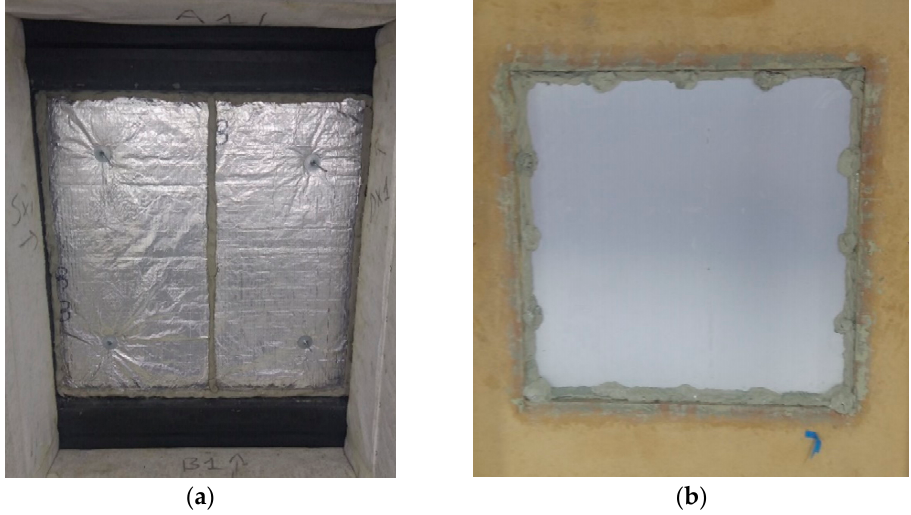
Figure 2. Experimental setup for STL measurement for benchmark solution: ( a ) hemi-anechoic chamber side view (mineral wool side); ( b ) reverberant room side view (honeycomb aluminum panel side).